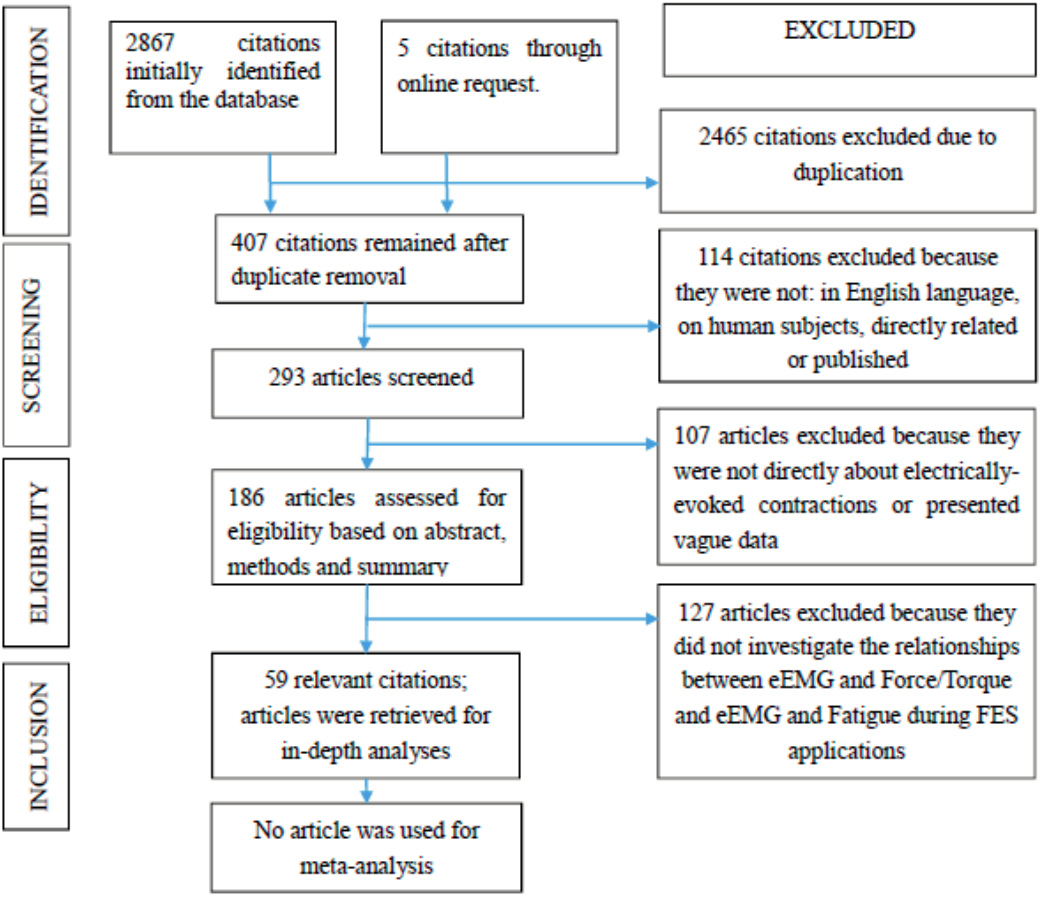
Figure 1. Flowchart of steps taken for the selected